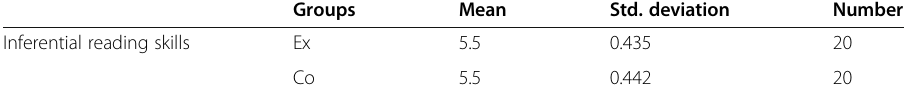
Table 3 Descriptive statistics of the pre-test scores in experimental and control groups